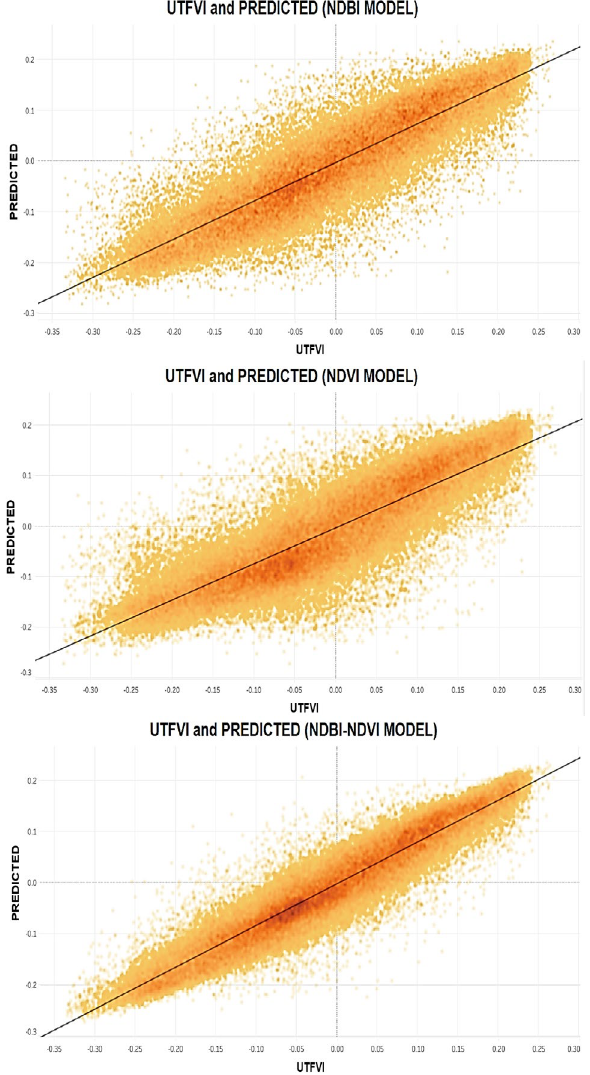
Figure 6. Scatter plots of UTFVI and RF-predicted UTFVI using NDBI (top), NDVI (middle), and NDBI-NDVI (bottom). Using both NDBI and NDVI results in less scatter of points with respect to the fitted